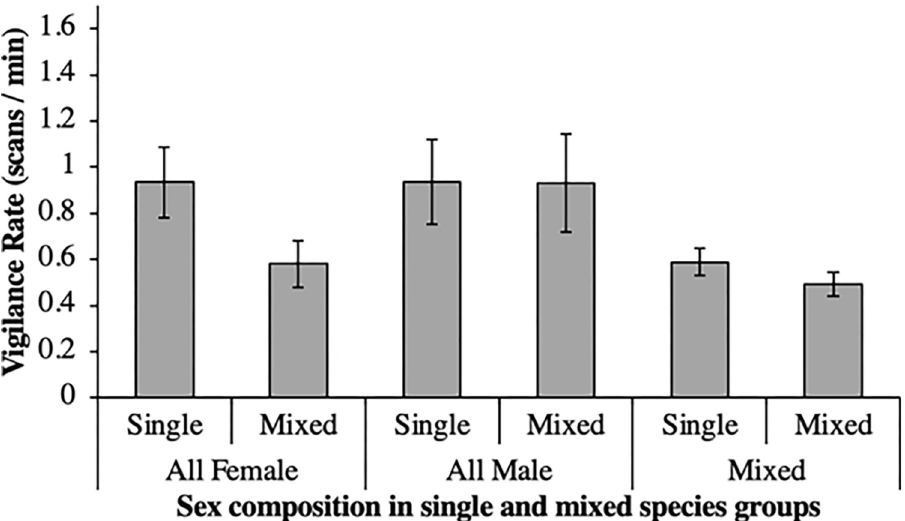
Fig 4. The rate of vigilance when animal groups of different sex compositions were observed across single and mixed species groups.